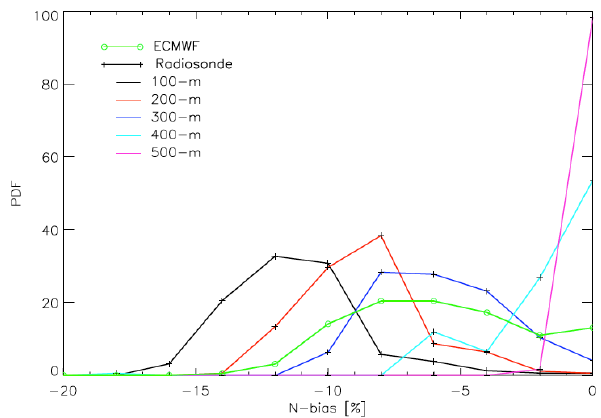
Fig. 6. PDF of the maximum N -bias due to ducting for radioson- Figure 6. PDF of the maximum N -bias due to ducting for radiosondes (190 profiles, with 3 des (190 profiles, with different vertical smoothing) and the near- different vertical smoothing) and the near-coincident ECMWF analysis over the region (15-4 coincident ECMWF analysis over the region (15–25 ◦ S, 70–86 ◦ W). 25°S, 70-86°W). The normalized PDF is multiplied by 2 to scale the maximum PDF close to 5 The normalized PDF is multiplied by 2 to scale the maximum PDF 100. 6 close to 7